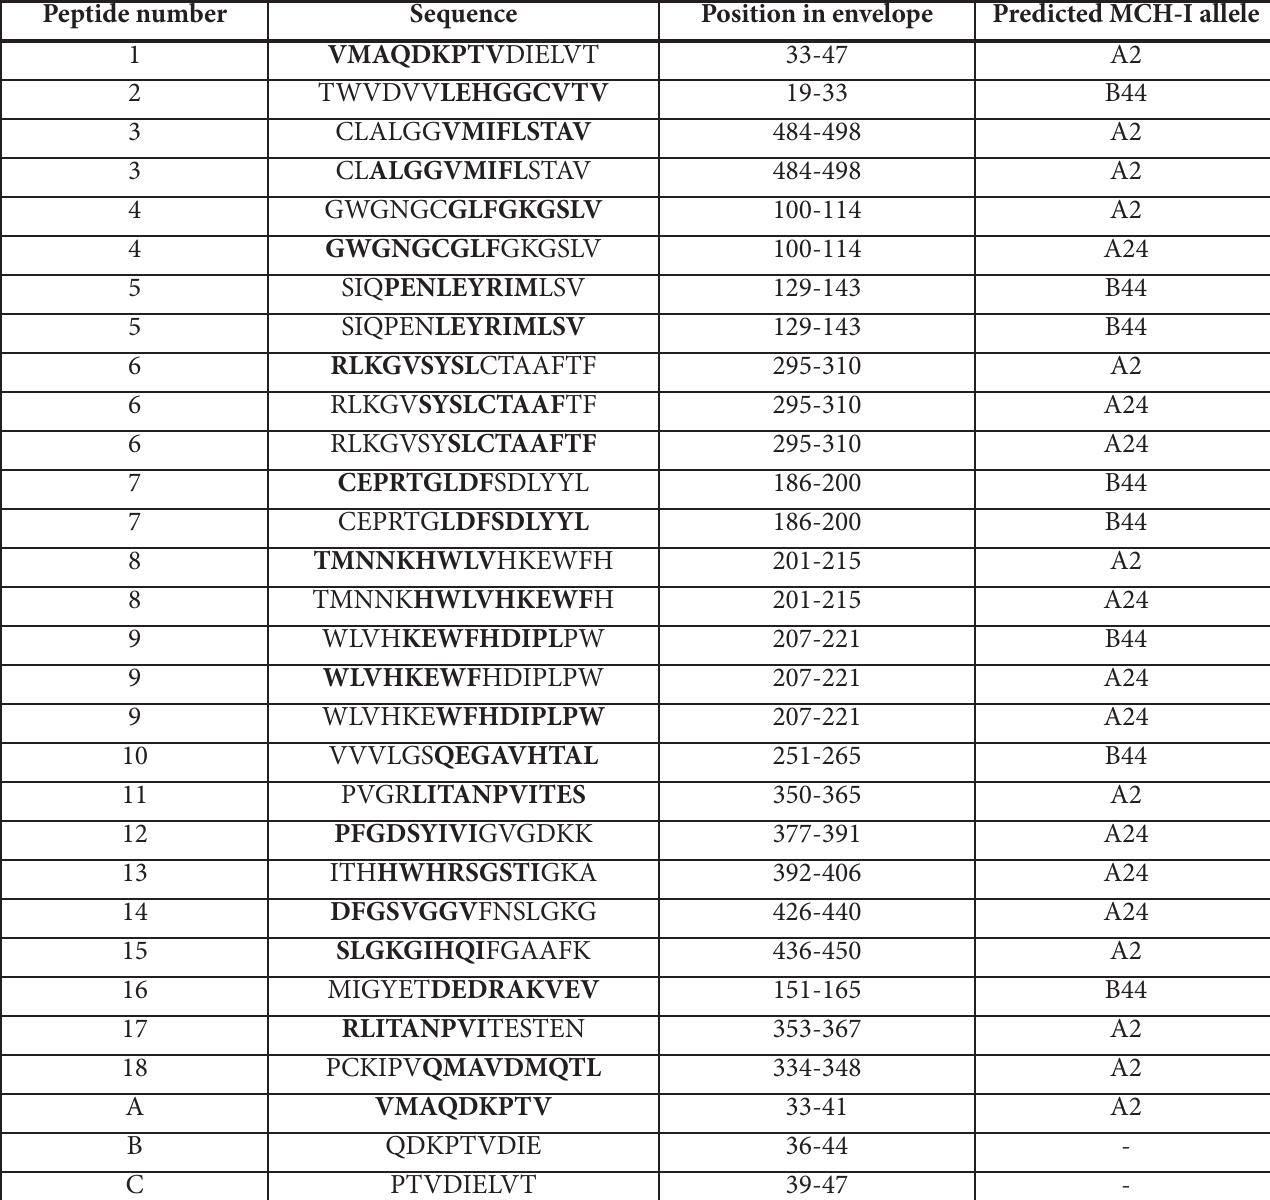
Table 2. Selected ZIKV Peptides Peptide number Sequence Position in envelope Predicted MCH-I